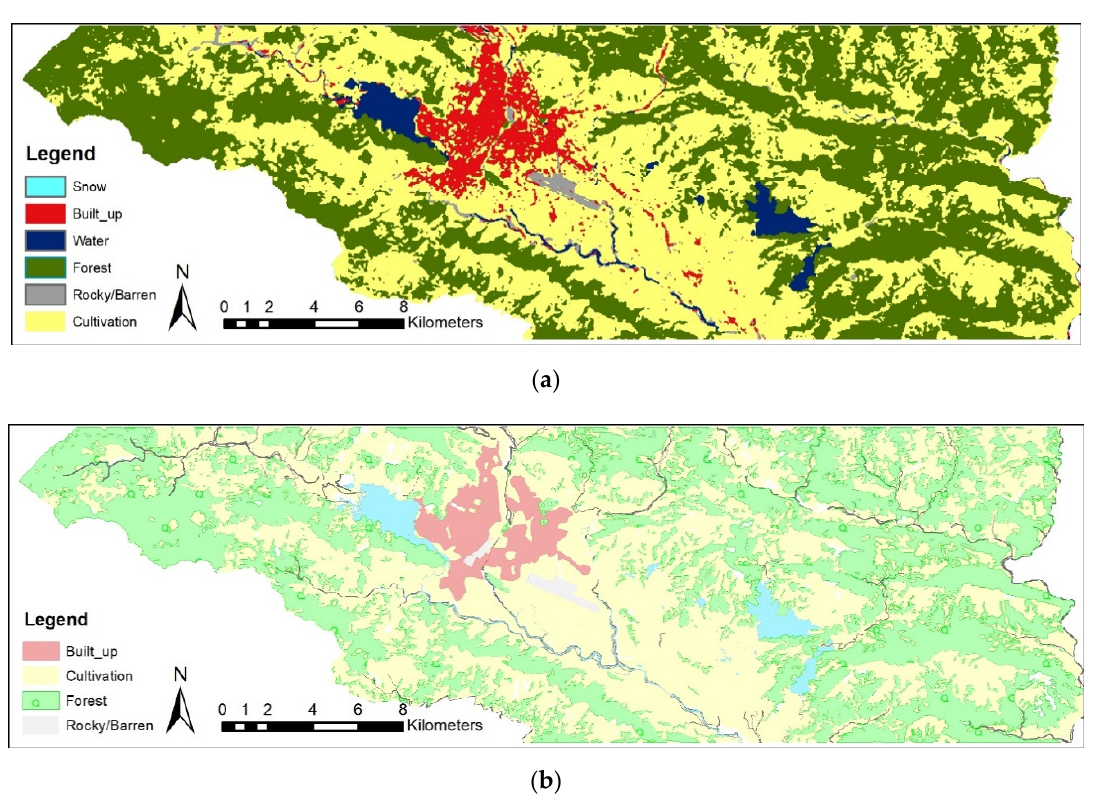
Figure 10. LC map of Pokhara area of the year 2020: ( a ) Map obtained from our study procedure; ( b ) map from a topographical map from the survey department.